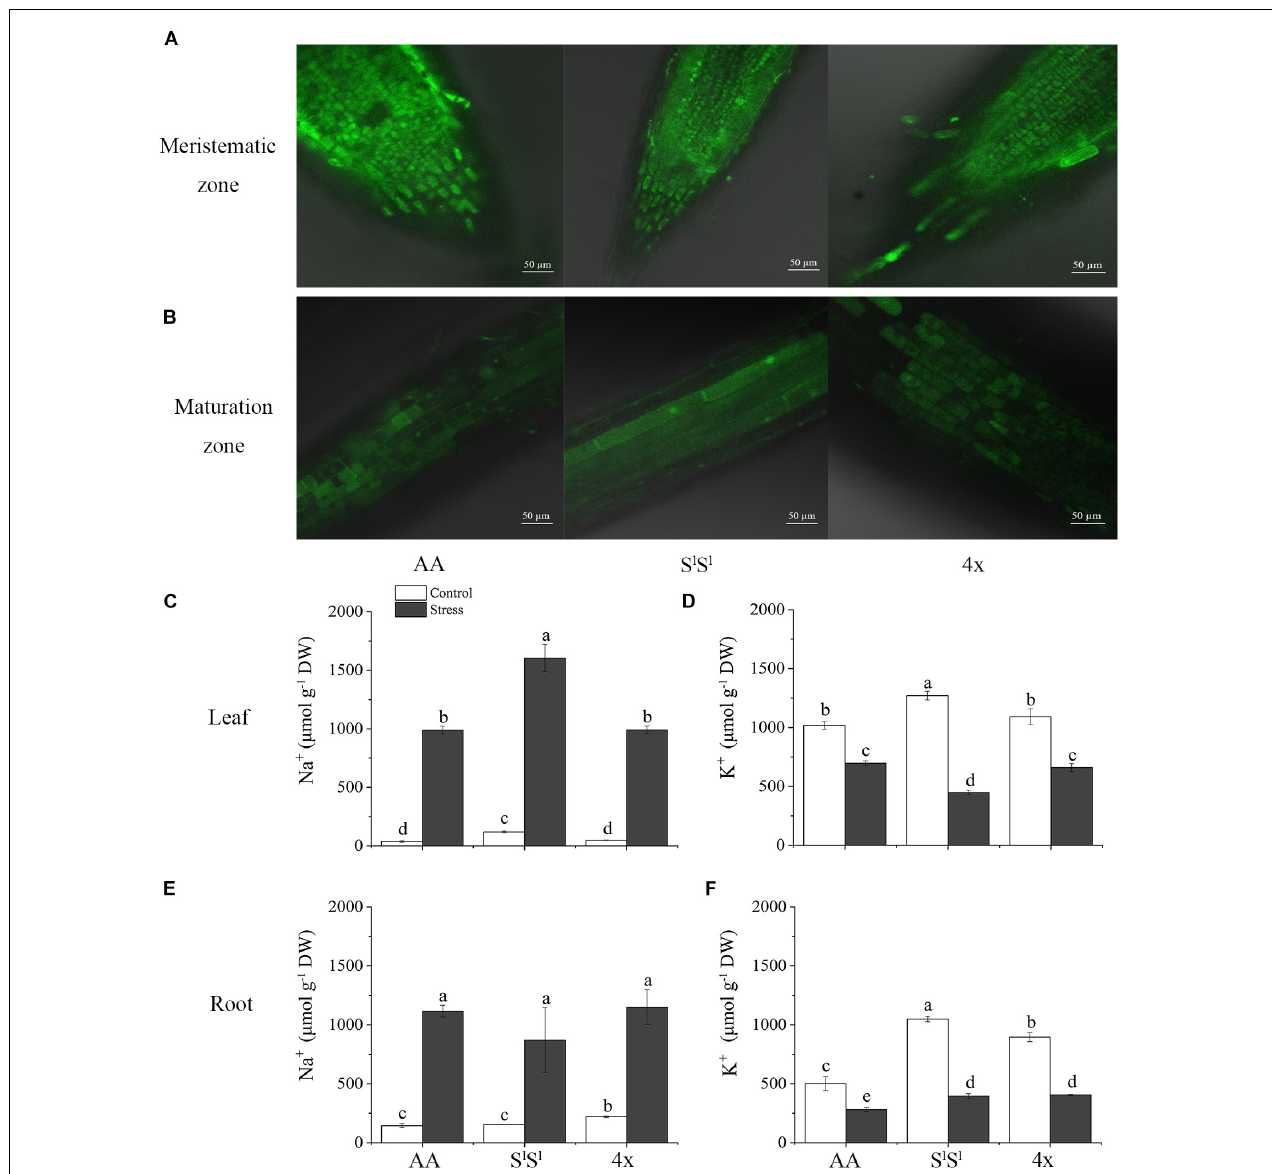
FIGURE 3 | Effects of salinity stress on Na + and K + homeostasis in a synthetic tetraploid wheat line and its diploid parents. (A,B) Na + distribution in root cell indicated by CoroNa Green AM under salinity stress. (C–F) Na + and K + concentration. The seedlings were exposed to 150 mM NaCl for 7 days. The values are the mean ( ± SD) of three biological replicates. Different letters above the bar showed significant differences among wheat lines and treatments according to t -test ( P <